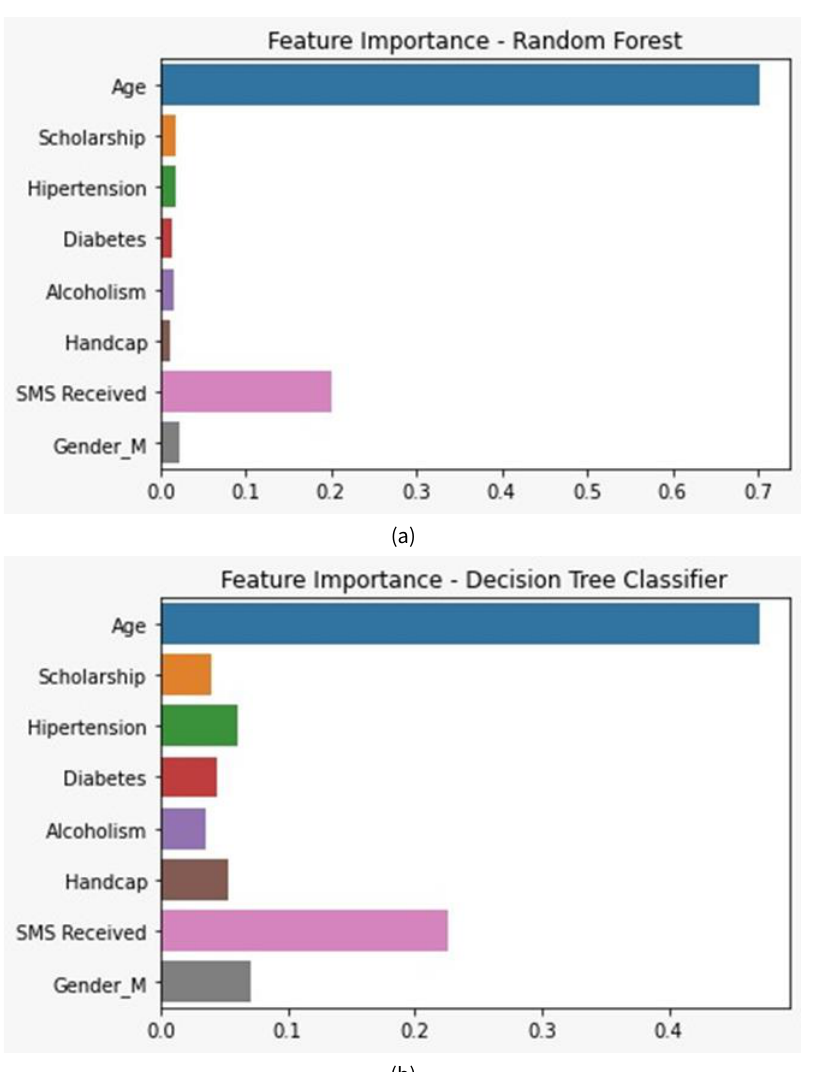
Figure 5. Importance of each attribute in the models generated from the Decision Tree (a) and Random Forest (b)